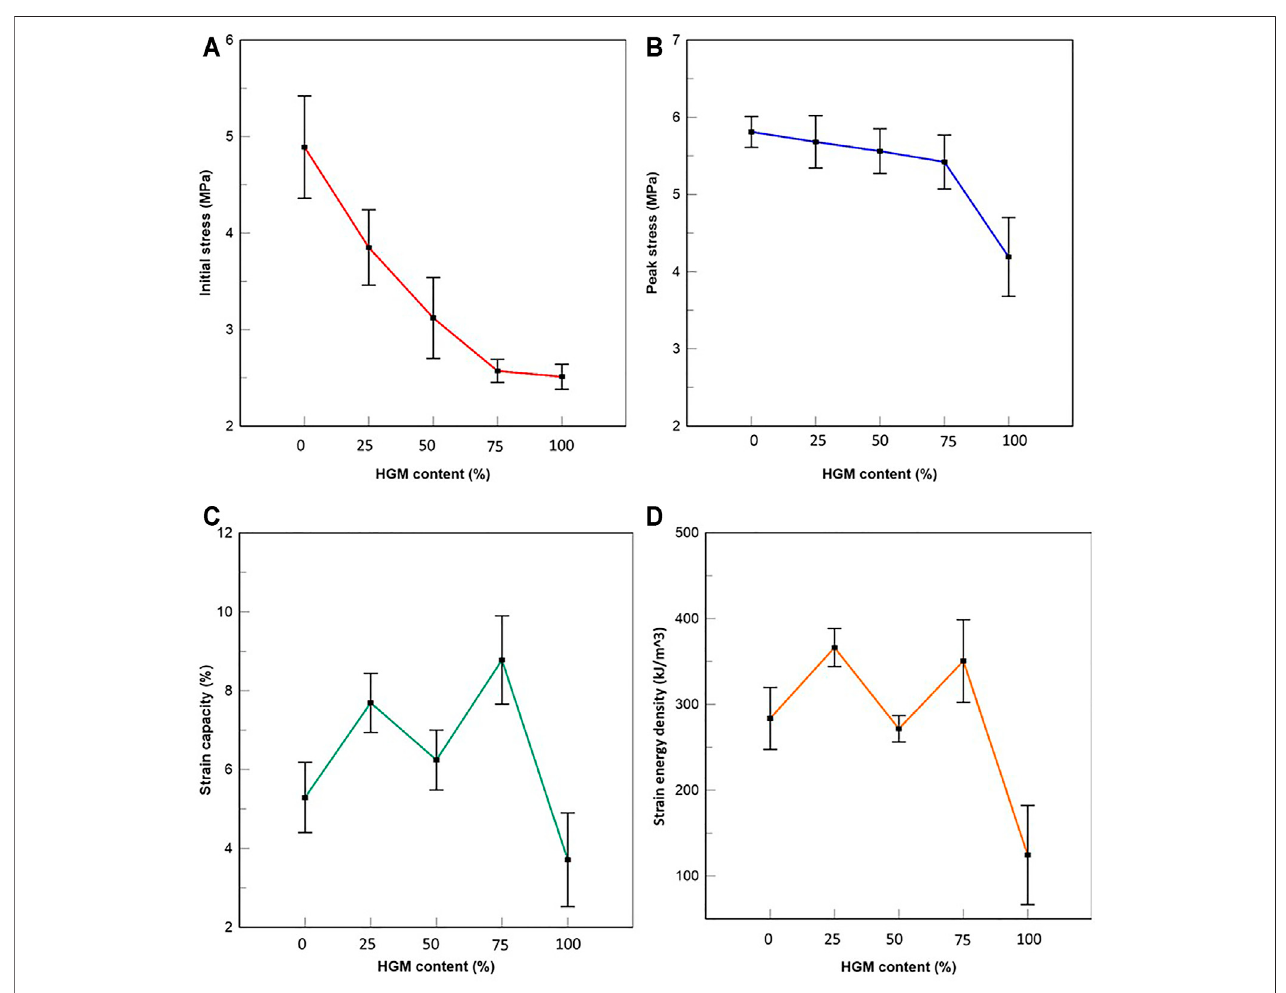
FIGURE 6 | (A) Initial stress of HGMLW-SHCC. (B) Peak stress of HGMLW-SHCC. (C) Strain capacity of HGMLW-SHCC. (D) Strain energy of HGMLW-SHCC.